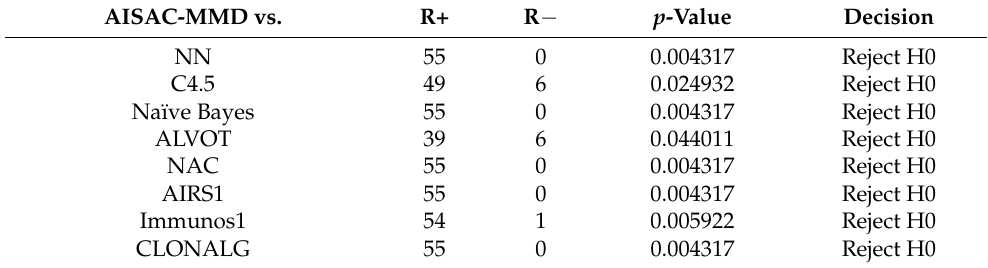
Table 5. Results of the Wilcoxon